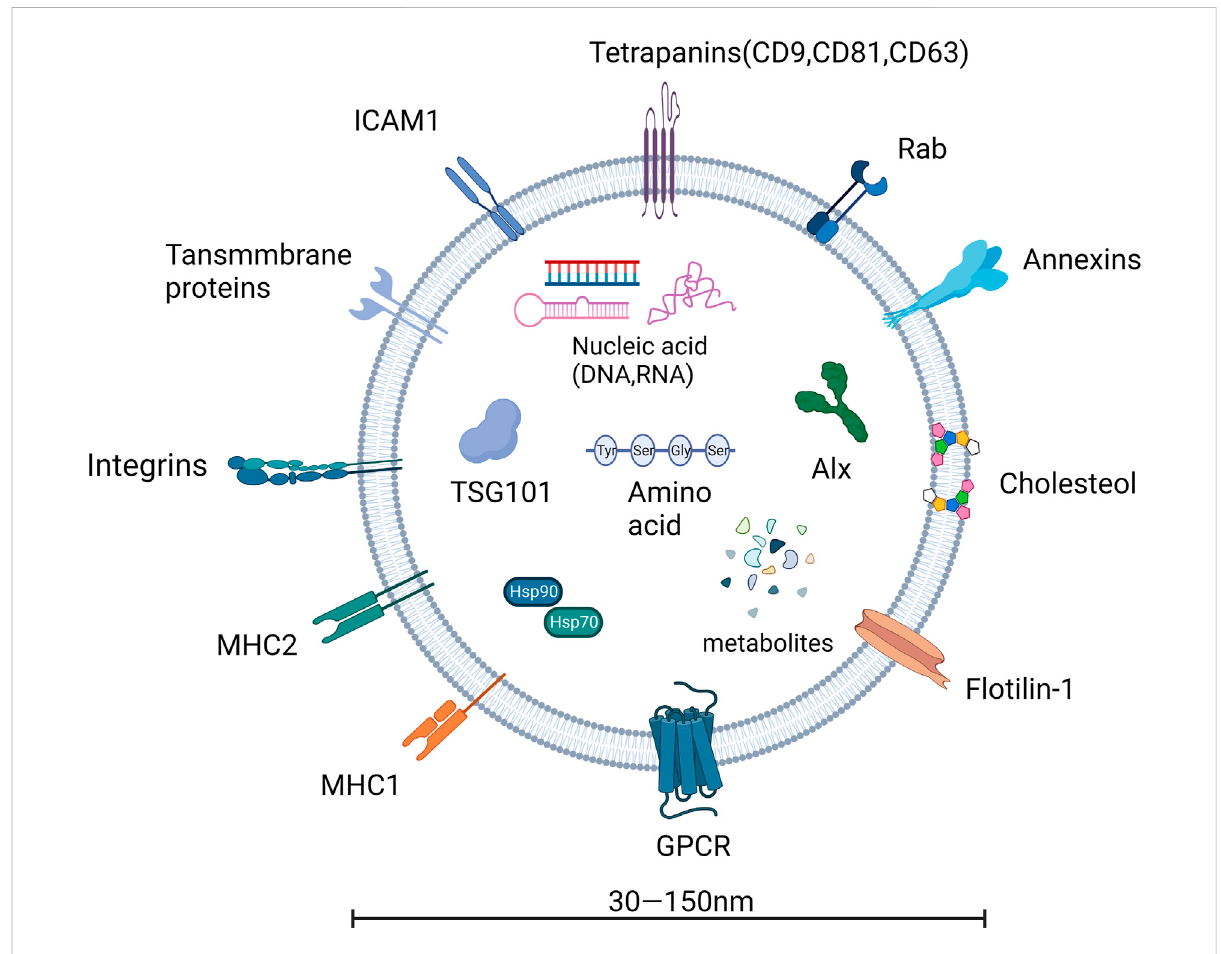
FIGURE 2 The basic structure of